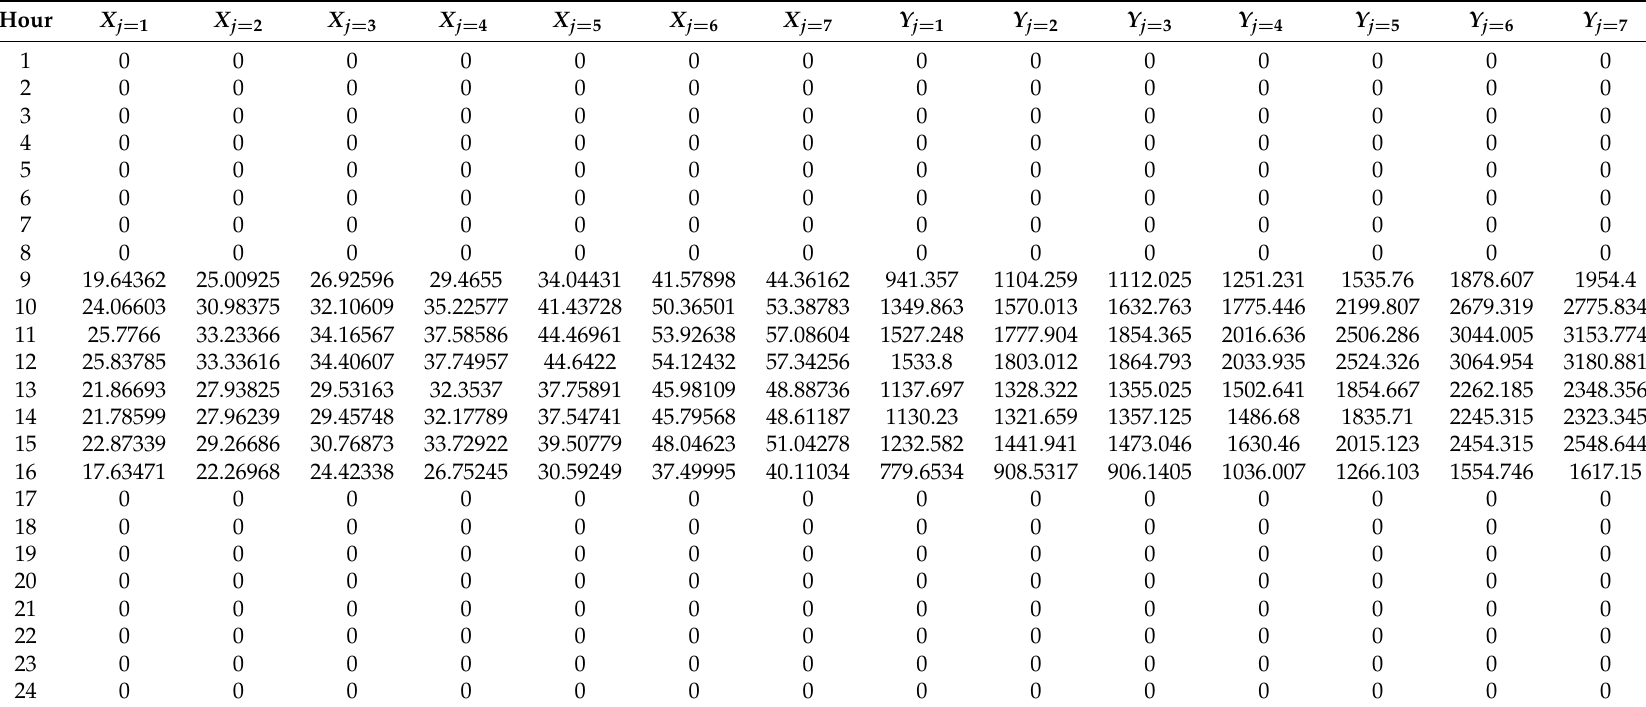
Table A8. Detailed demand response results for Case